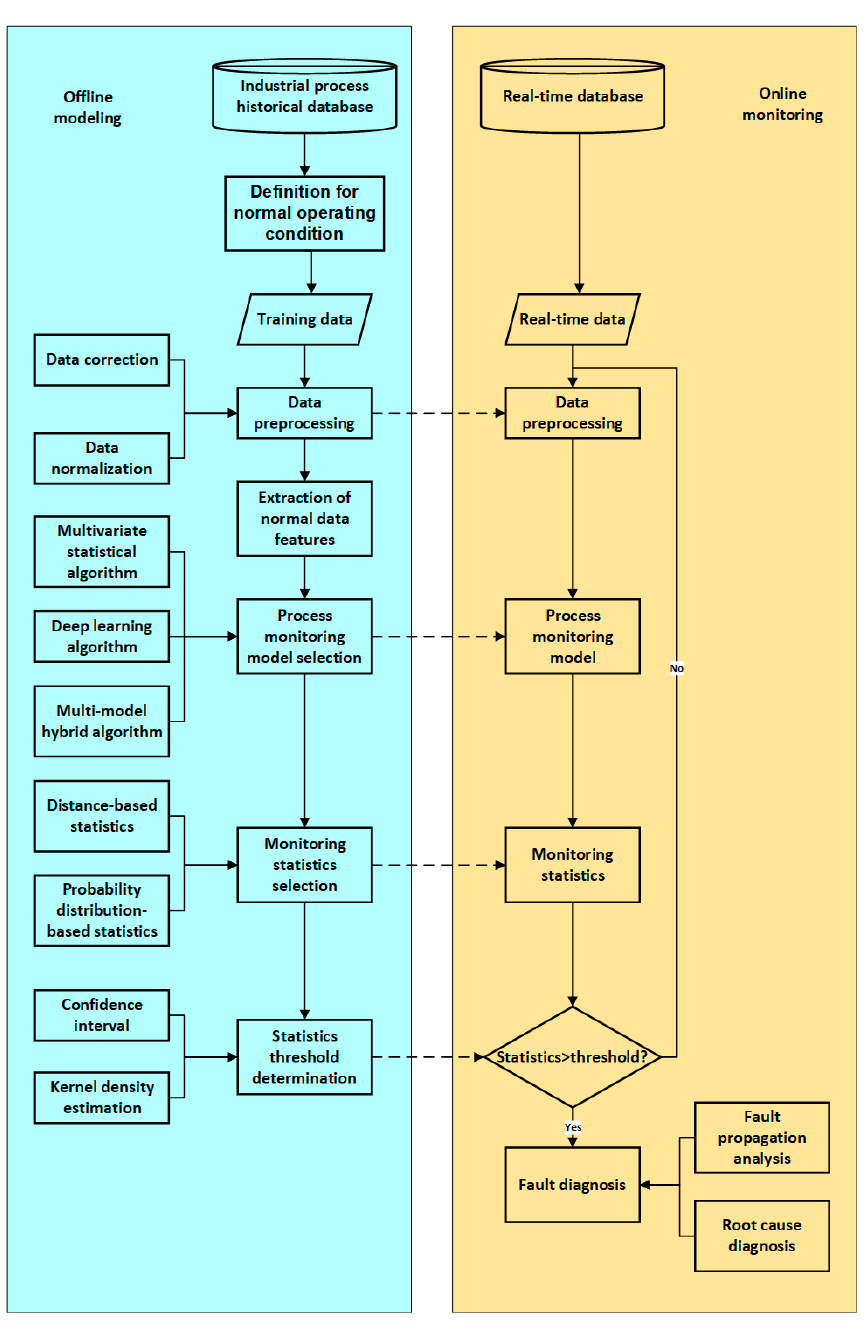
Figure 3. Data-driven industrial process monitoring